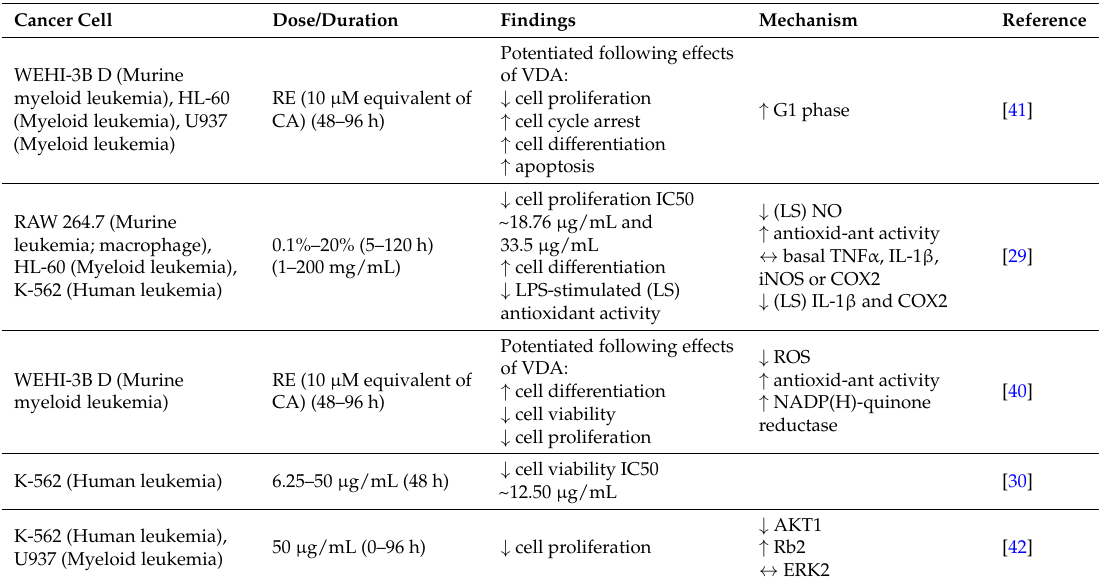
Table 5. Anticancer effects of Rosemary Extract (RE). In vitro studies: leukemia. Cancer Cell Dose/Duration Findings Mechanism